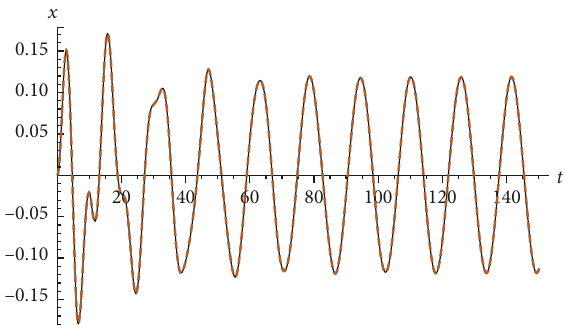
Figure 10: Comparison between the approximate analytical solution and the numerical solution for Example